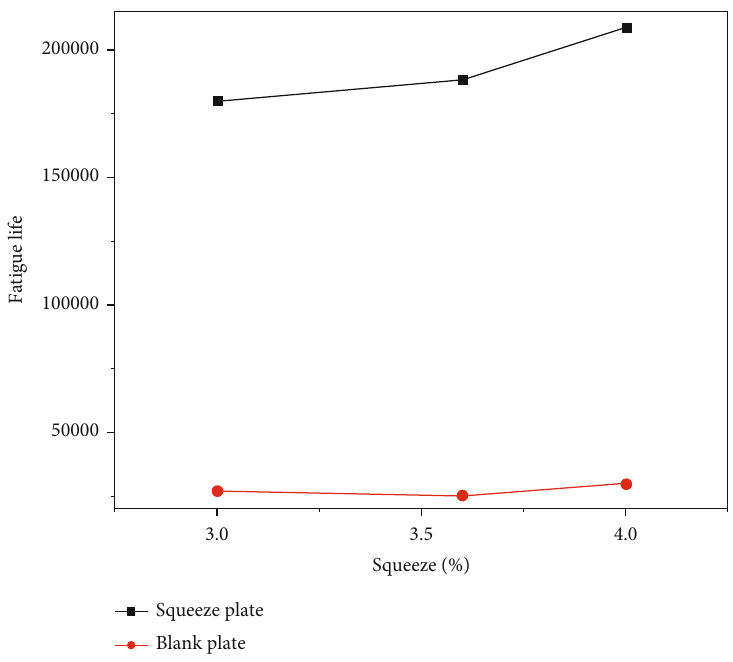
Figure 16: Comparison of fatigue life under di ff erent squeezing Table 3: Comparison of experimental life and simulated life under di ff erent reaming amounts.